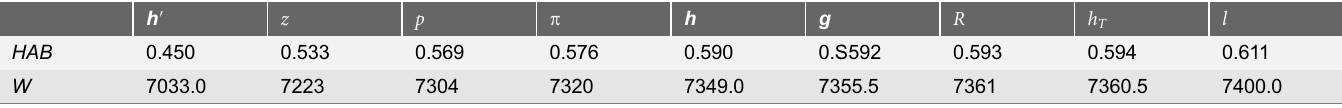
Table 4. Analysis of the habilitation variable.